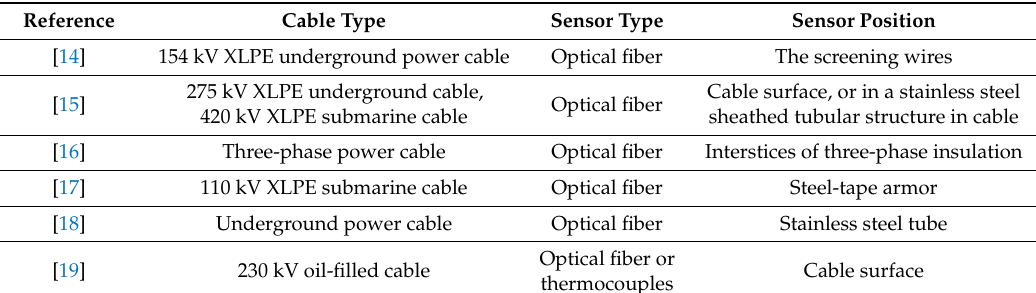
Table 1. Radial positions of the sensor in practical